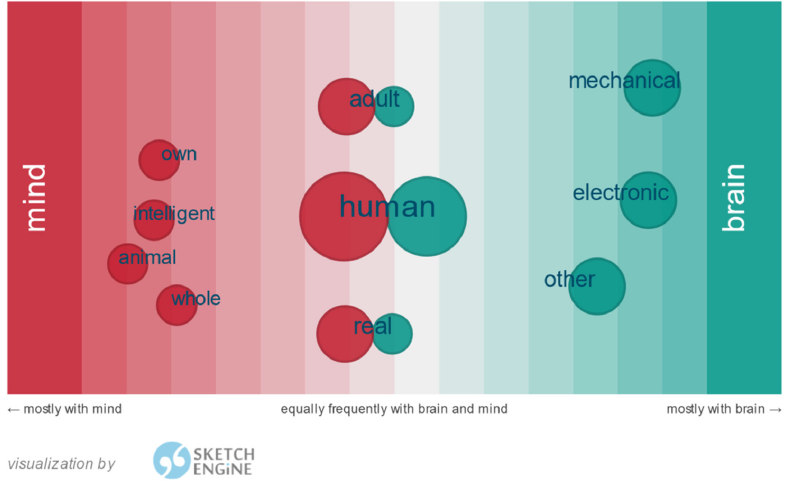
Figure 6. A comparison of adjectival predicates that accompany the terms “mind” and “brain”. To the left, we find the terms associated mostly with “mind”, and to the right, those associated with “brain”.